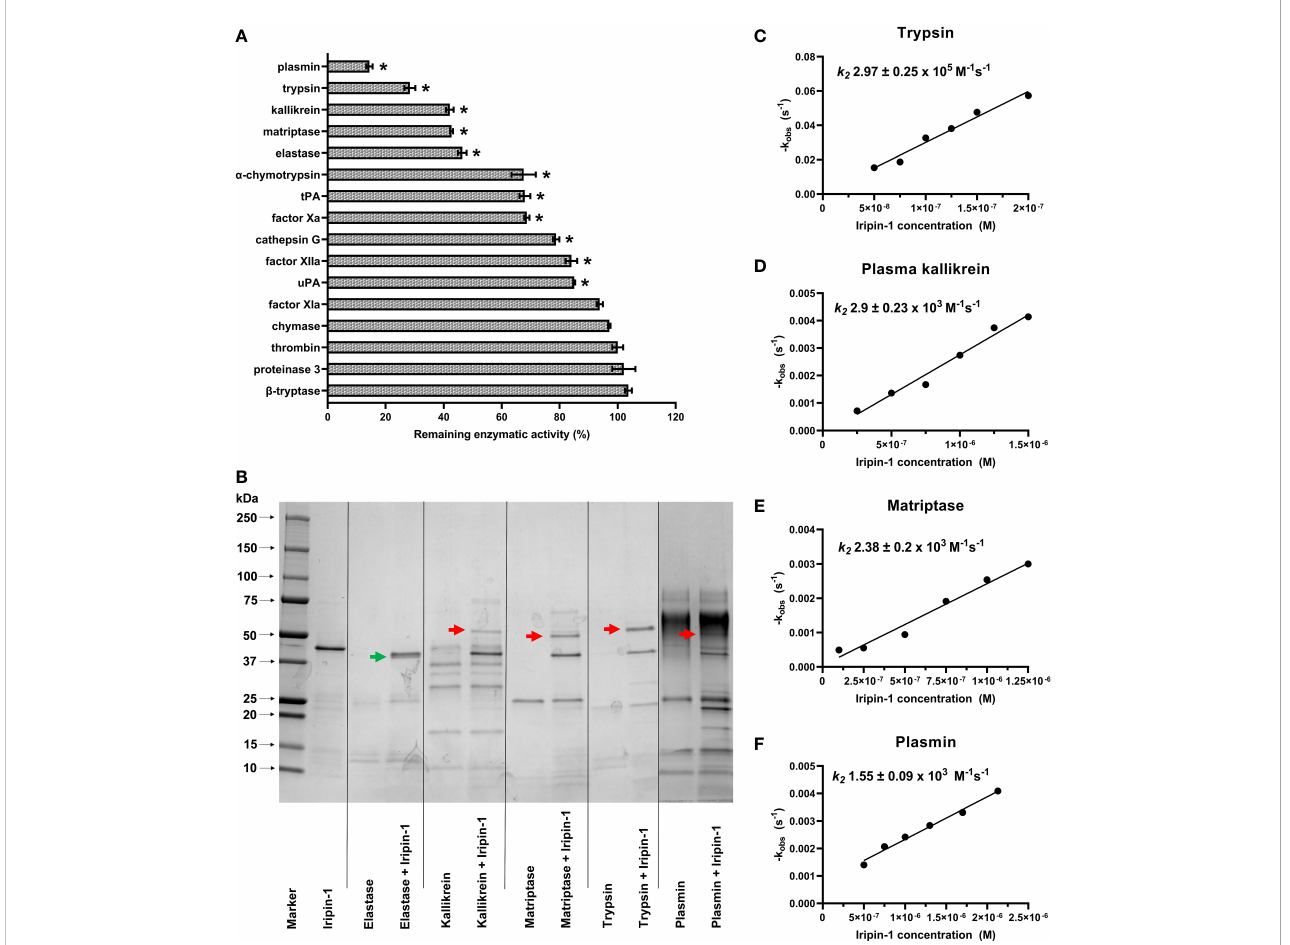
FIGURE 4 Iripin-1 inhibits trypsin, kallikrein, matriptase, and plasmin via a classic serpin inhibitory mechanism. (A) The Iripin-1 inhibitory activity against 16 selected serine proteases. The enzymatic activities of individual proteases in the presence of 200 nM Iripin-1 were compared to the substrate hydrolysis rate (set to 100%) in the absence of Iripin-1 and expressed as a percentage. The assay was conducted in triplicate, and data are expressed as mean values ± SEM. Statistically signi fi cant reduction (p < 0.05) of proteolytic activity after the incubation of the enzyme with Iripin-1 is marked with an asterisk. tPA, tissue- type plasminogen activator; uPA, urokinase-type plasminogen activator. (B) Formation of covalent complexes between Iripin-1 and elastase, kallikrein, matriptase, trypsin, and plasmin. Proteases and Iripin-1 were incubated at equimolar concentrations for 1 h at 37°C, and the presence of complexes was detected by reducing SDS-PAGE. Red arrows point to covalent complexes formed between Iripin-1 and individual proteases, and a green arrow points to Iripin-1 cleaved in its RCL by neutrophil elastase. (C-F) Determination of inhibition constants. The apparent fi rst-order rate constant k obs was plotted against six different Iripin-1 concentrations, and linear regression was performed to obtain the line of best fi t. The slope of the line represents the second-order rate constant k 2 for the inhibition of trypsin (C) , plasma kallikrein (D) , matriptase (E) , and plasmin (F) by Iripin-1. For each determination, the standard error of the slope is